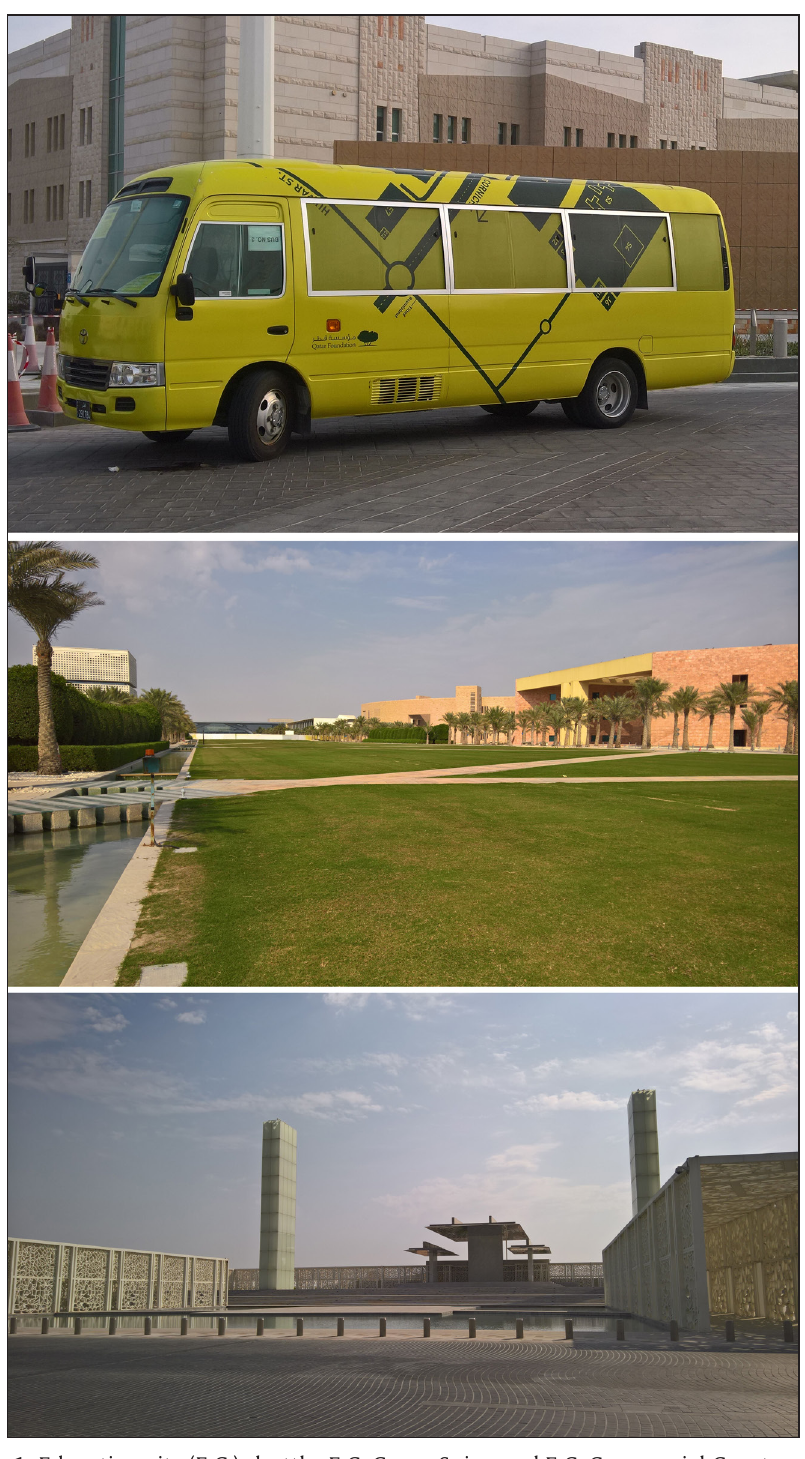
Figure 1: Education city (E.C.) shuttle, E.C. Green Spine and E.C. Ceremonial